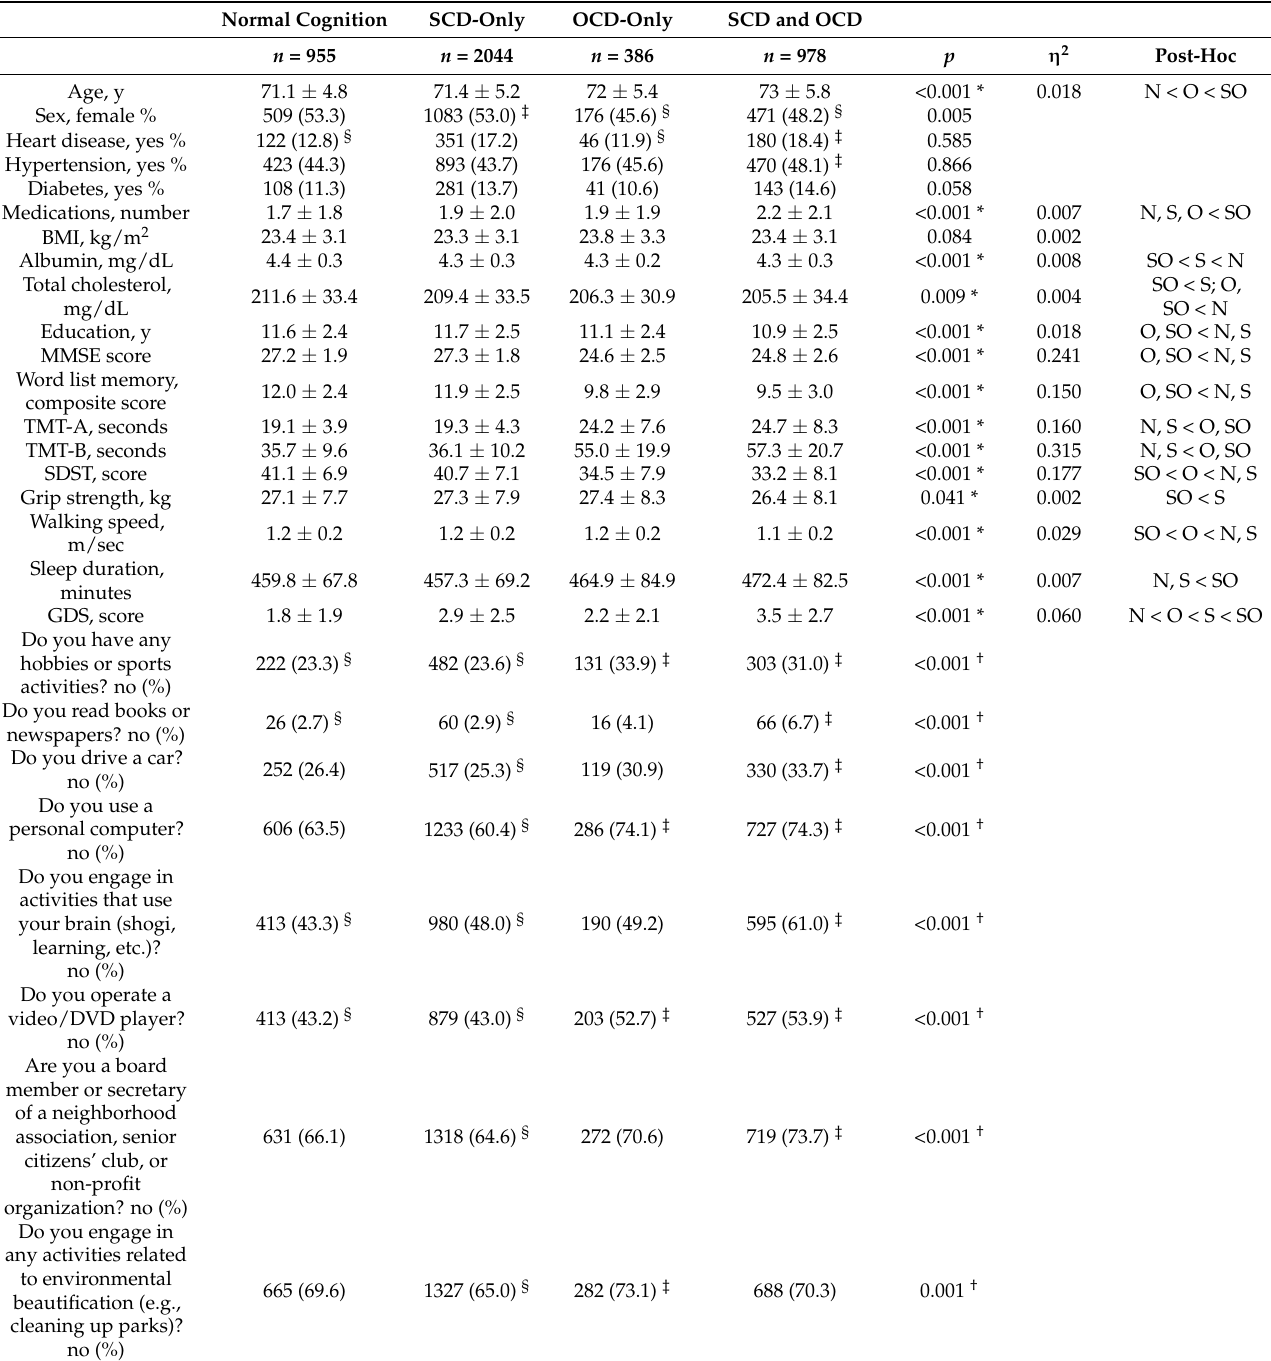
Table 2. Comparisons of potential confounders and cognitive status at